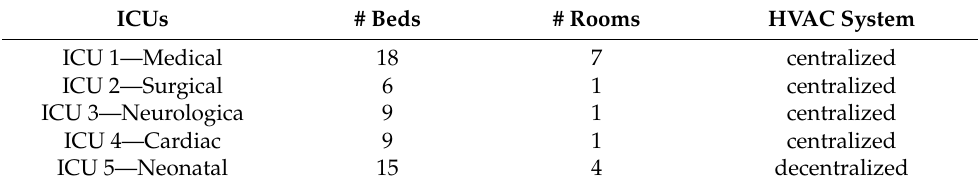
Table 1. ICUs involved in the investigation. (#: